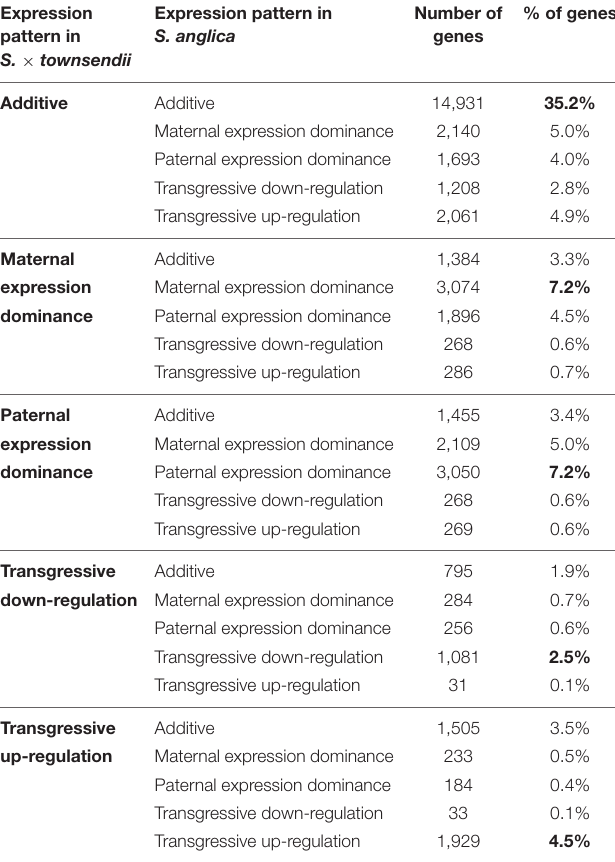
TABLE 6 | Origin of haplotypes identified for three genes transgressively up-regulated following hybridization and genome doubling in S. × townsendii and S.